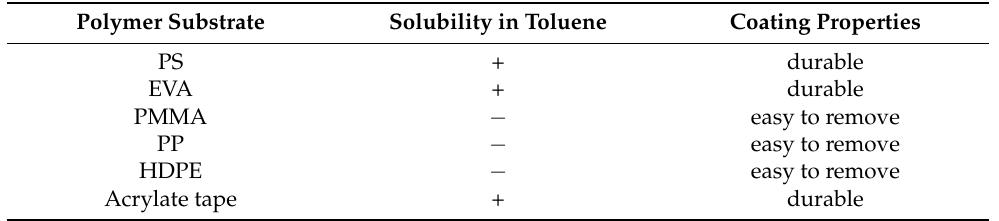
Table 1. Properties of ZnO nanoparticle coatings deposited on different polymeric substrates. Polymer